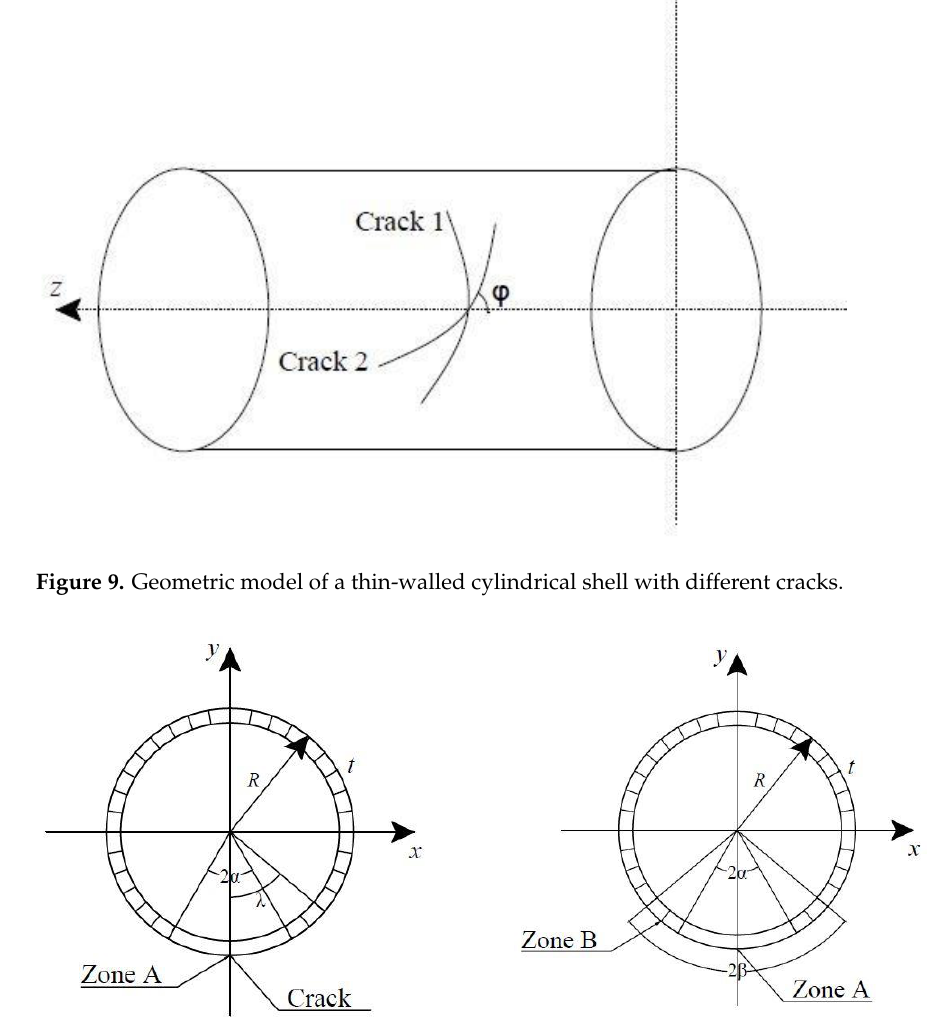
Figure 10. Crack sections for linear elastic and elastic-plastic materials. ( a ) Section with circumfer- ential crack for linear elastic material; ( b ) Section with circumferential crack for elastoplastic mate- rial.